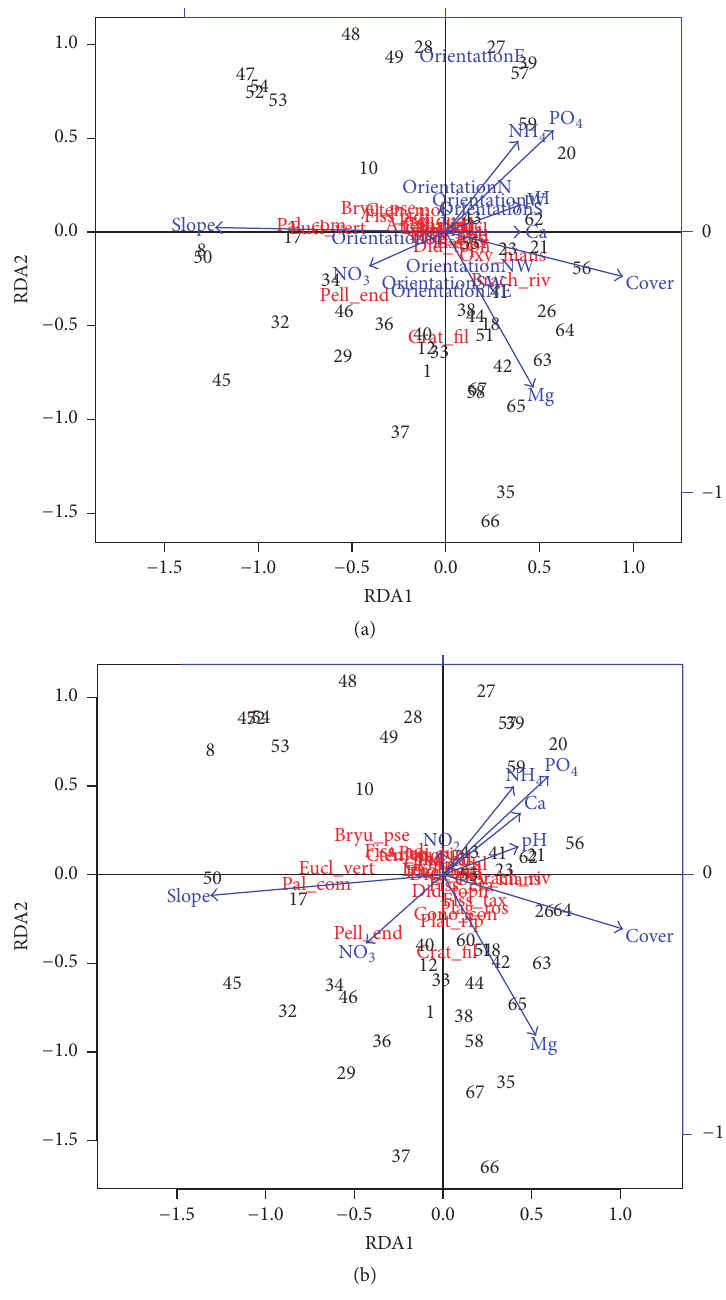
Figure 2: Plot of the tb-RDA analysis with (a) and without (b) orientation